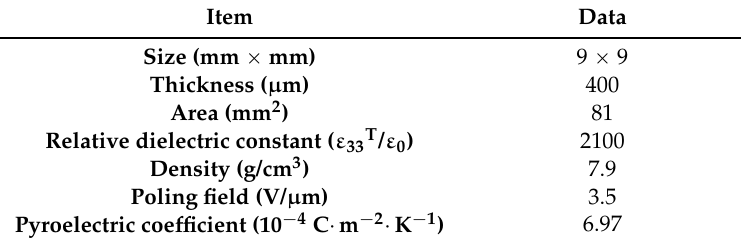
Table 1. Geometry and properties of the commercial PZT pyroelectric sheet.